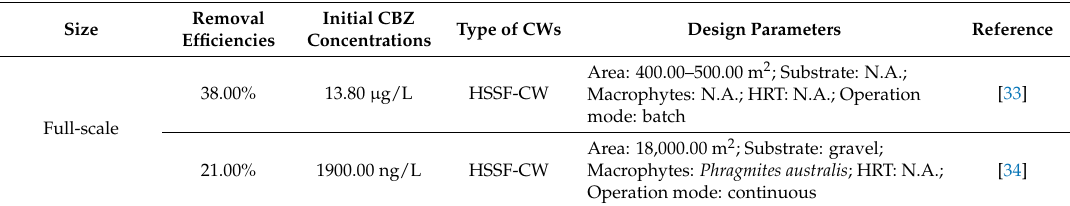
Table 1. Design parameters of the reported constructed wetlands as an alternative secondary wastewater treatment system for the removal of carbamazepine